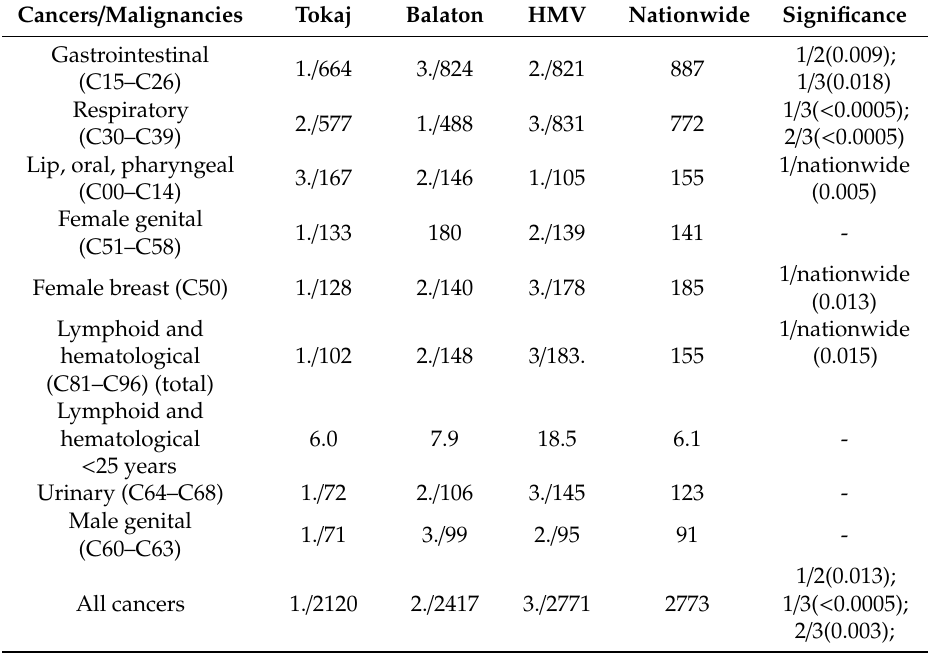
Table 2. The age-adjusted death rate (AADR) values of various types of cancers / malignancies in the three regions and nationwide between 2000 and 2010. Cancers / Malignancies Tokaj Balaton